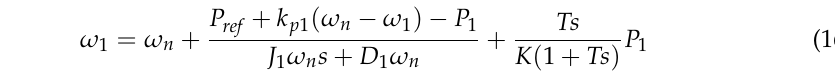
where K and T are the proportional coefficient and time constant of the high-pass filter,